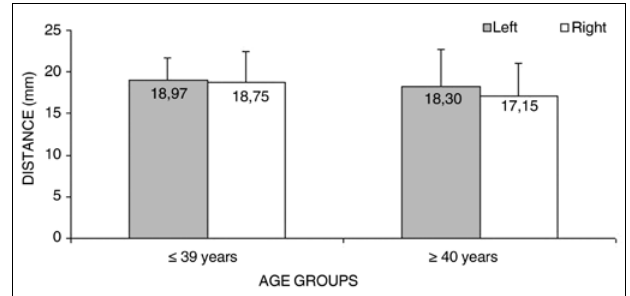
Figure 8. Measurement 5 relative to age and side, in mm (mean ± standard deviation) - measurement 5 (the shortest measurement from the EBSLN to the midline of the neck on the most cranial point of the cricoid